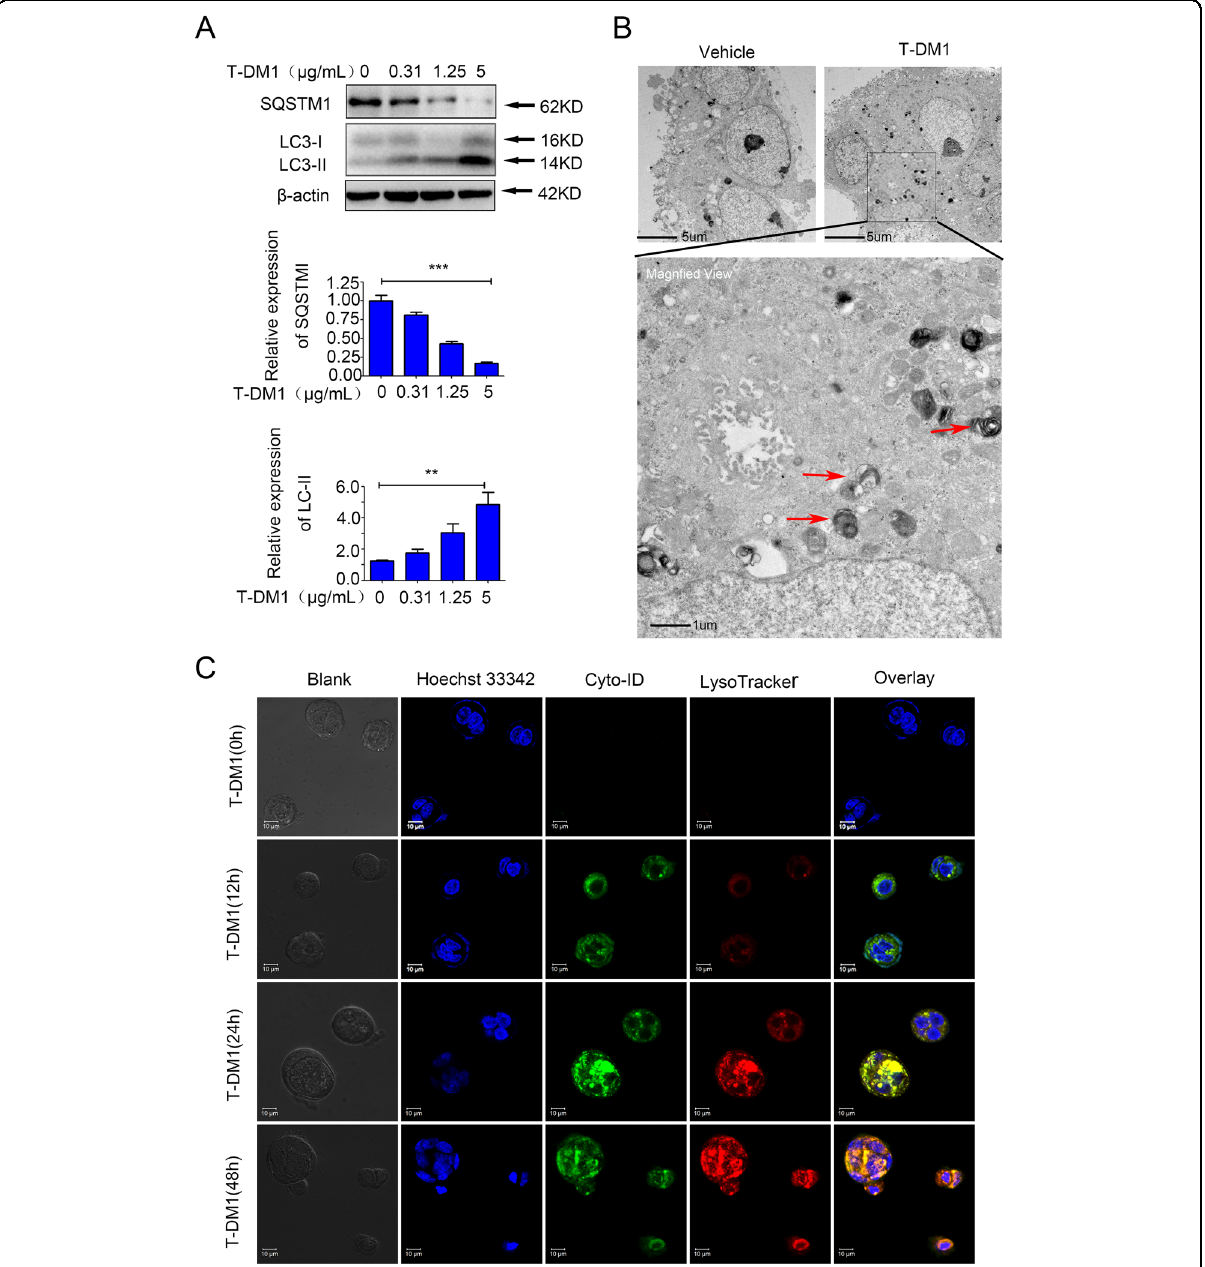
Fig. 3 Autophagosomes were induced in HER2-positive GC cells by T-DM1 treatment. A NCI-N87 cells were incubated with T-DM1 for 48 h. The levels of SQSTM1 and LC3-II were analyzed by immunoblot analysis. ImageJ software was employed to estimate densitometric values and to normalize the densitometric values to the corresponding control value. The results of control were set as 1.0, and the data are presented as the mean ± S.D. of 3 independent experiments. Student t -test was used to compare the data. * P < 0.05, ** P < 0.01, and *** P < 0.001. B NCI-N87 cells were interfered with T-DM1 for 24 h, and TEM was used to detect ultrastructural autophagosomes shown in the electron photomicrograph. c Autophagic fl ux and lysosomes in NCI-N87 cells treated with T-DM1 for speci fi c times were evaluated by Cyto-ID Green staining and LysoTracker Red